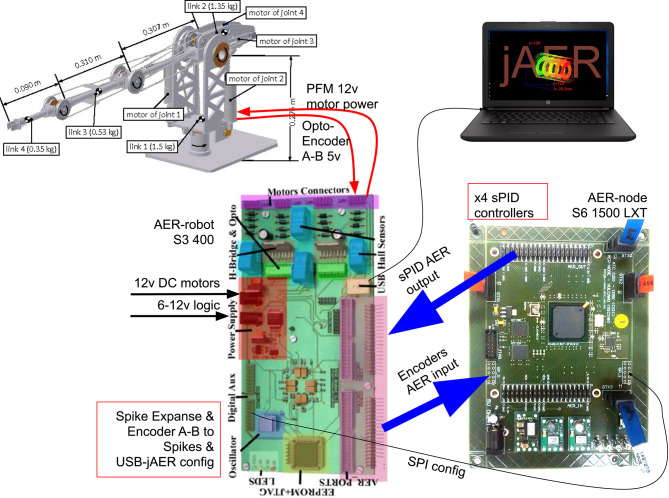
BioRob structure.